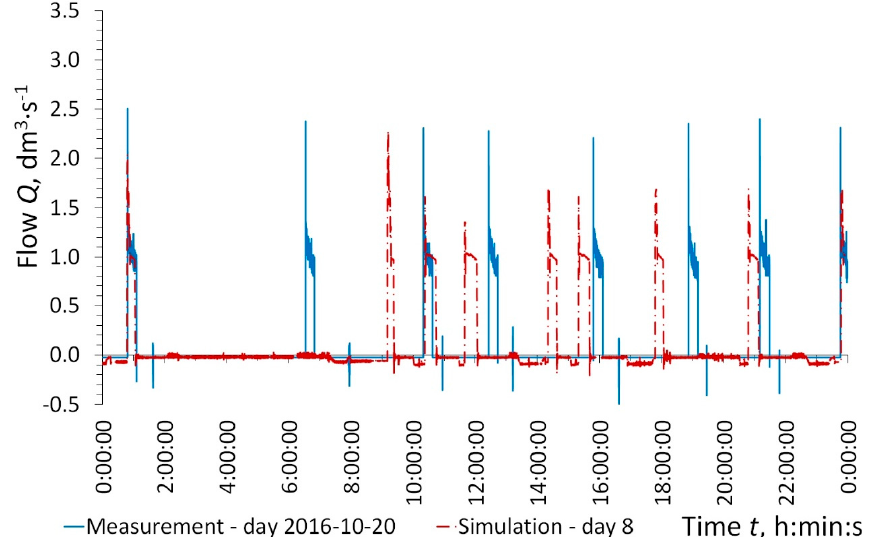
Figure 13. Flows in force main measured on 20 October 2016 and simulated for day 8 using the SWMM 5.1 program.